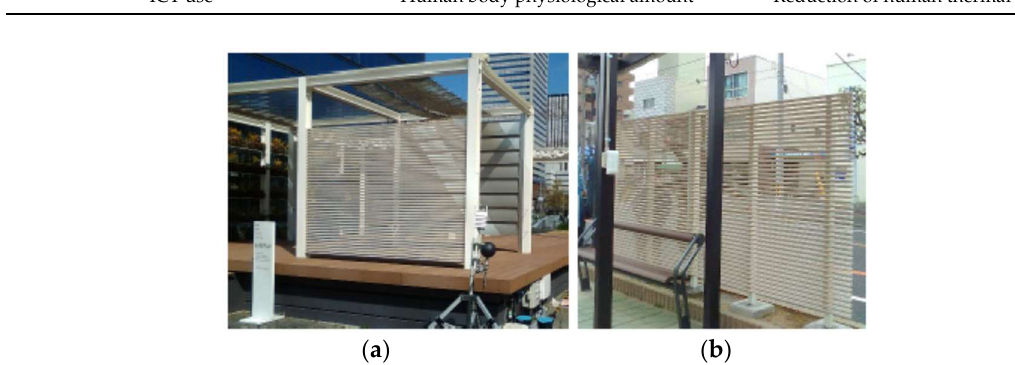
Figure 3. Evaporative cooling louver, which is provided by Prof. Misaka. ( a ) in a park; ( b ) at a tram